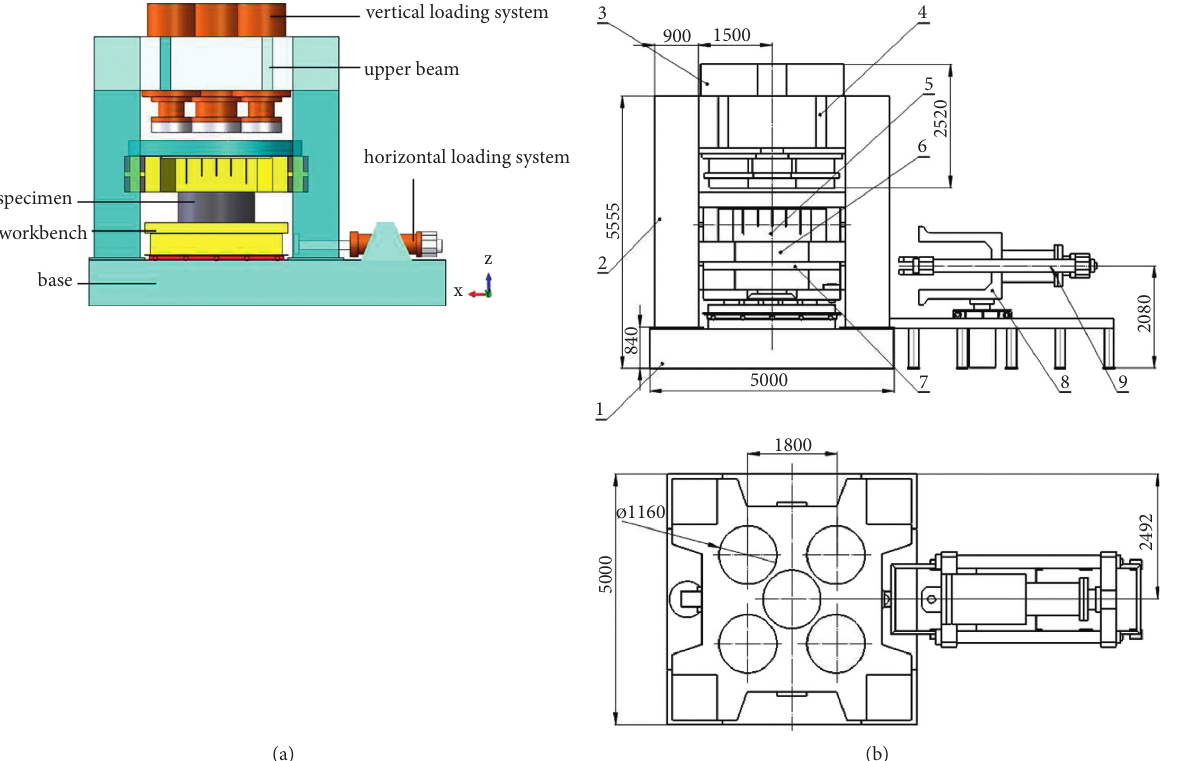
Figure 1: Structure drawing and technical drawing of 6000t compression-shear test machine. (a) Overall layout of 6000t compression-shear test machine. (b) Technical drawing of 6000t compression-shear test machine. (1) Base; (2) column; (3) hydraulic cylinder; (4) upper beam; (5) upper platen; (6) specimen; (7) cylinder; (8) double shear